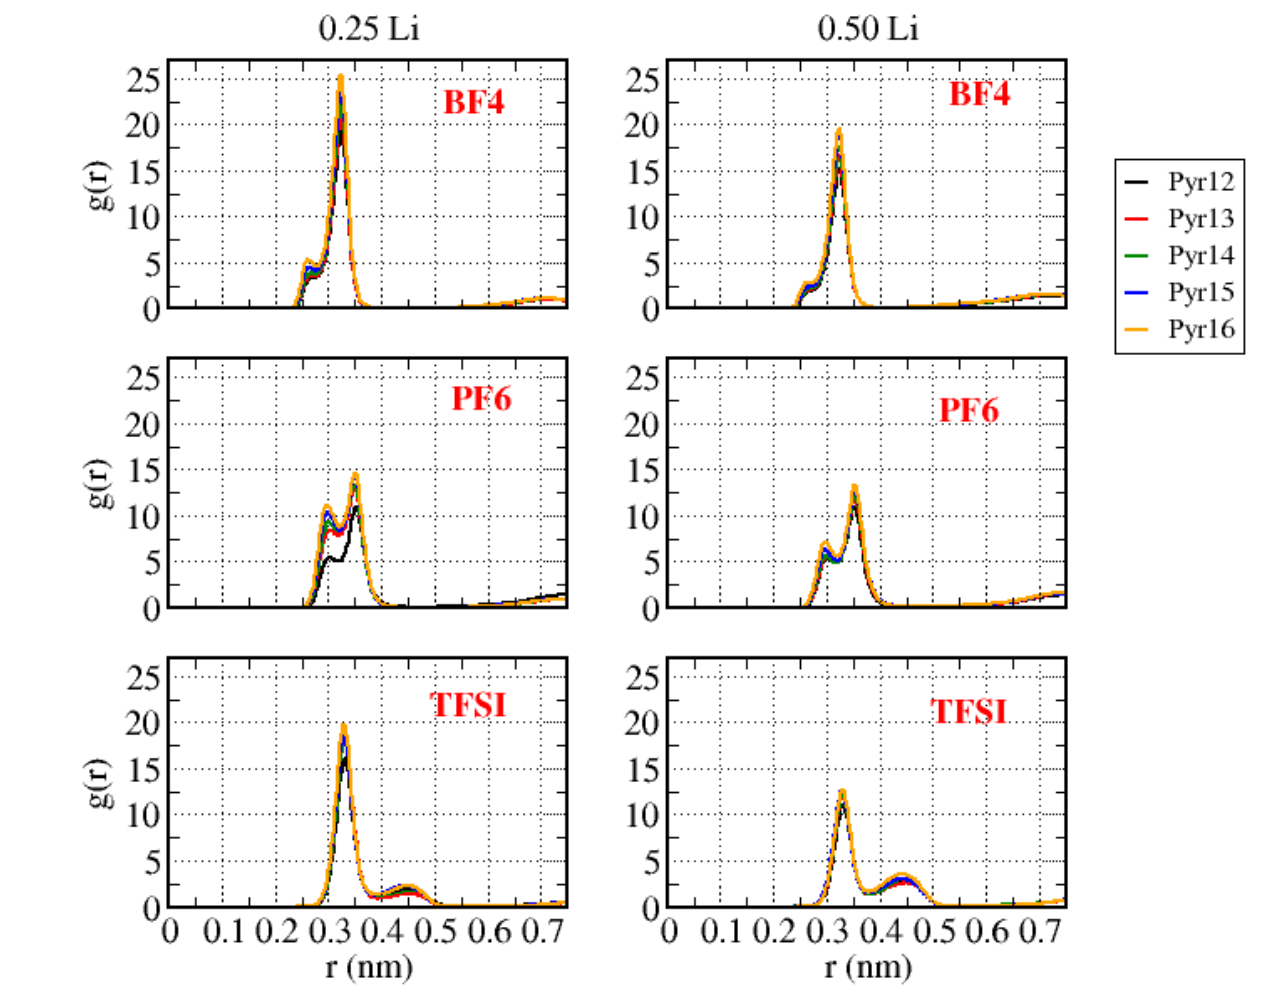
Figure 11. Center-of-mass Li–anion g ( r ) for all the systems with different amounts of lithium. Systems with a larger fraction of lithium (0.50 Li) had a similar trend depending on the size of the pyrrolidinium cation for systems with BF4 and PF6 as the anions, considering that the average number of anions around the lithium ions was in the range 1.5–2.0, while for TFSI as the anion, the average was close to 1.0 for the systems. For all systems